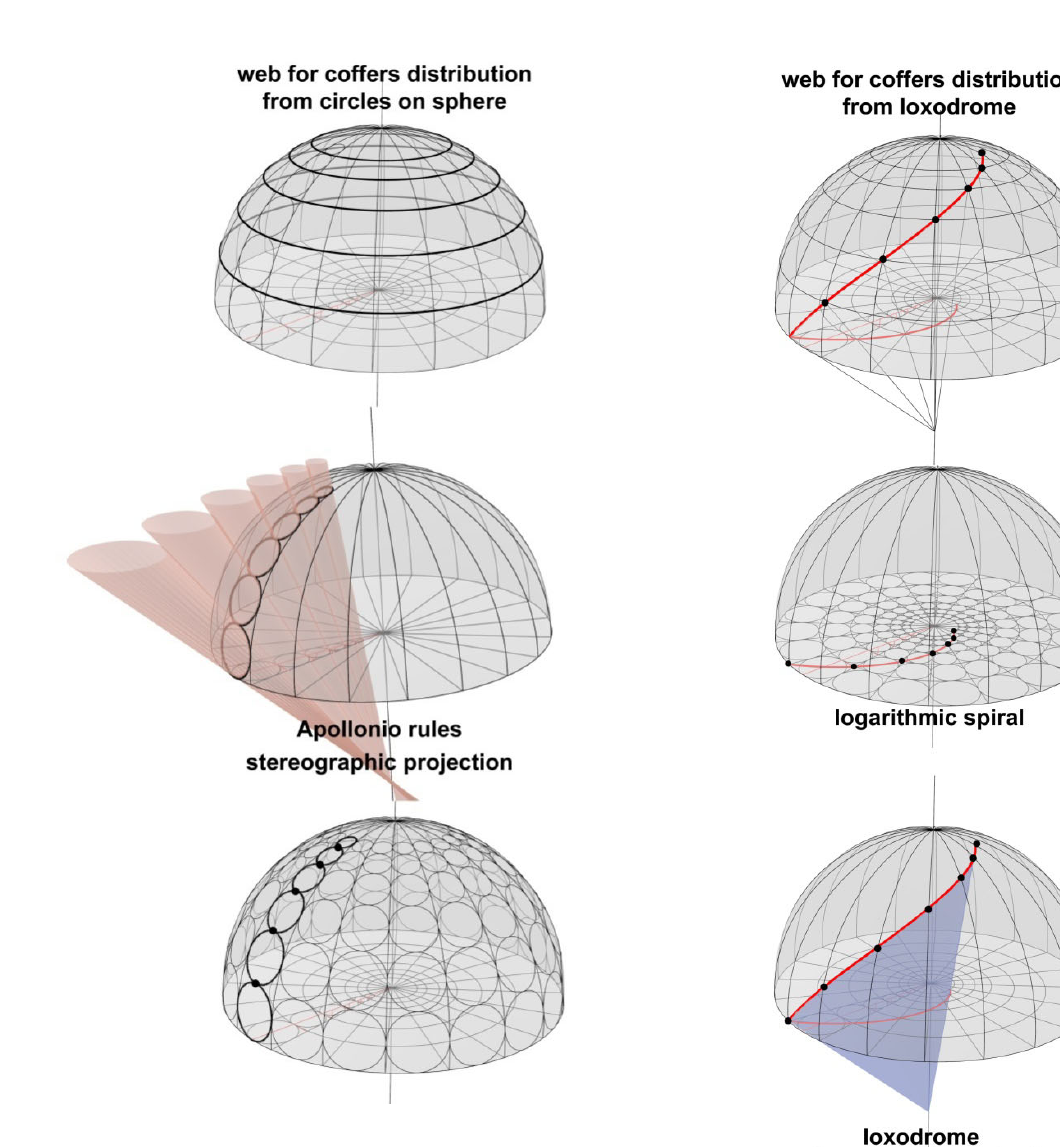
Figure 12. Generative modeling for coffers distribution on hemispherical dome using